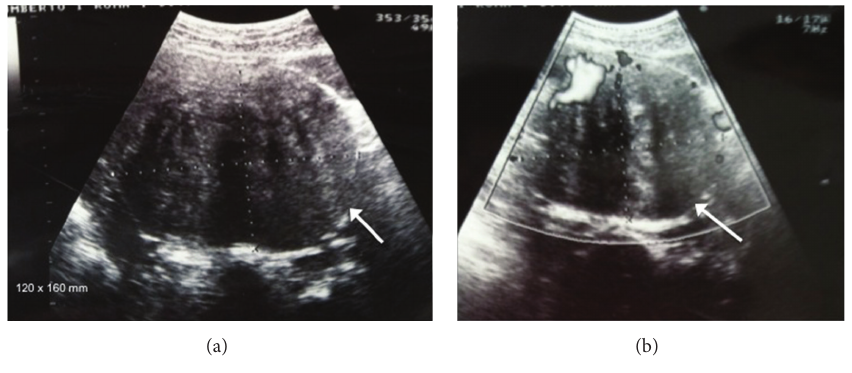
Figure 1: Myoma at ultrasonographic exam.